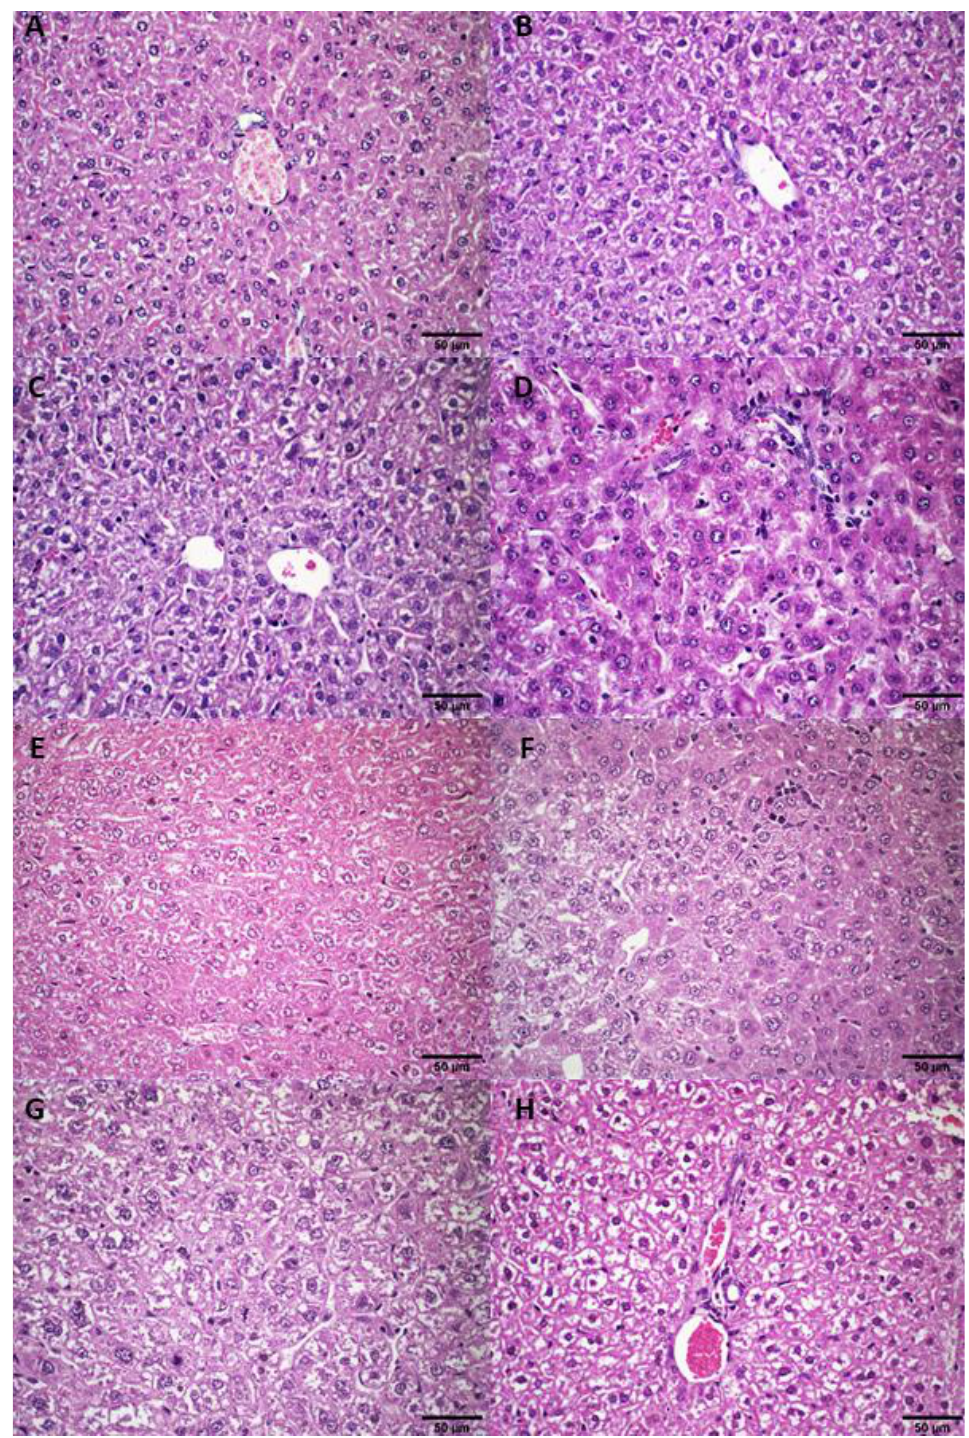
Figure A3. Histological sections of female Balb/c mice liver. ( A ) Control group (HBS), ( B ) ExoSpHL, and ( C ) SpHL-DOX at a dose of 15 mg/kg, ( D ) ExoSpHL-DOX at a dose of 15 mg/kg, ( E ) DOX at a dose of 10 mg/kg, ( F ) DOX at a dose of 12.5 mg/kg, ( G ) SpHL-DOX at a dose of 17.5 mg/kg, ( H ) ExoSpHL-DOX at a dose of 17.5 mg/kg.